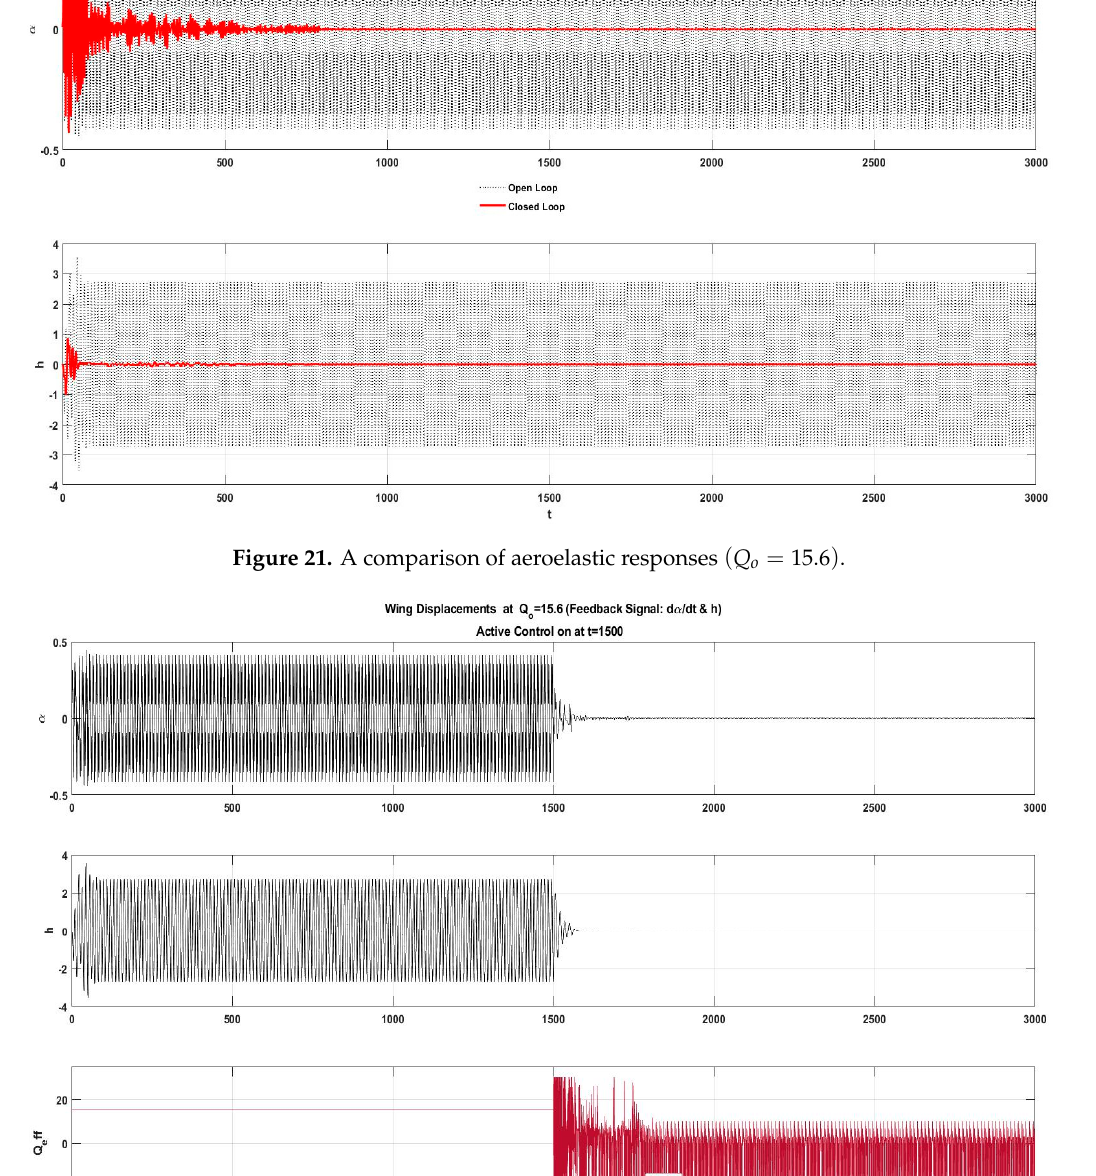
Figure 22. Aeroelastic response to control at t = 1500.